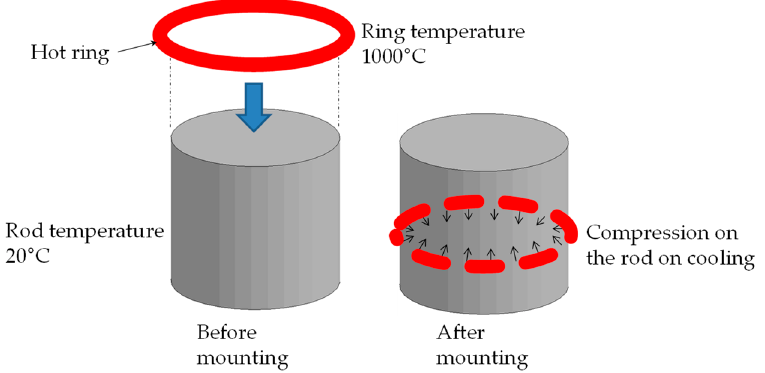
Figure 2. A conventional method of reinforcing a metal rod using the shrinkage of a metal ring.